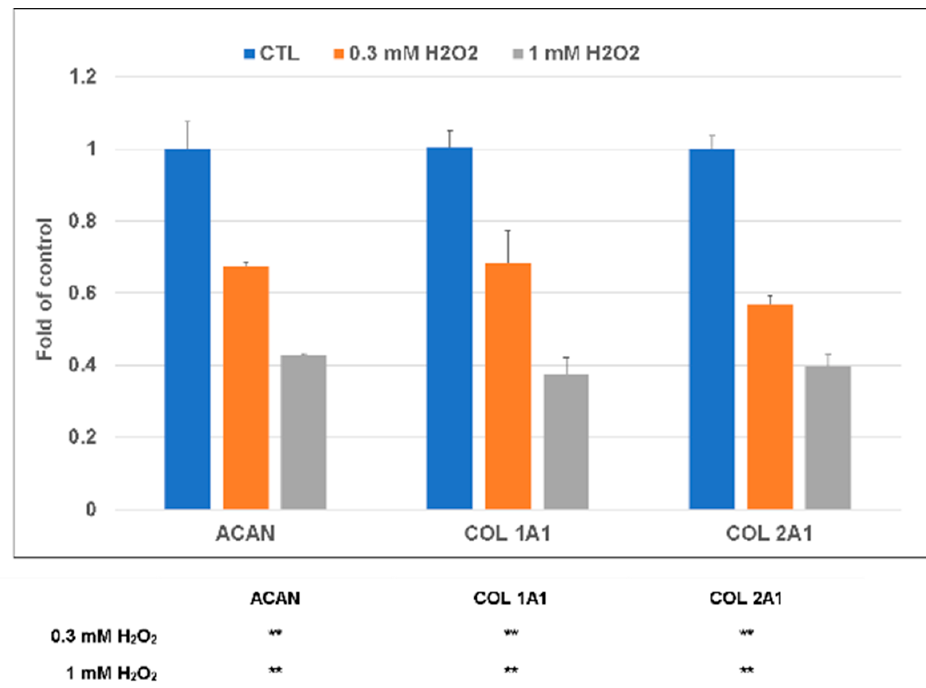
Figure 4. Gene expression of chondrocytes under oxidative stress in the presence of H 2 O 2 oxidative stress, the expression of COL1A1, COL2A1, and aggrecan (ACAN) genes were downregulated. ** P < 0.01 when compared with control group.